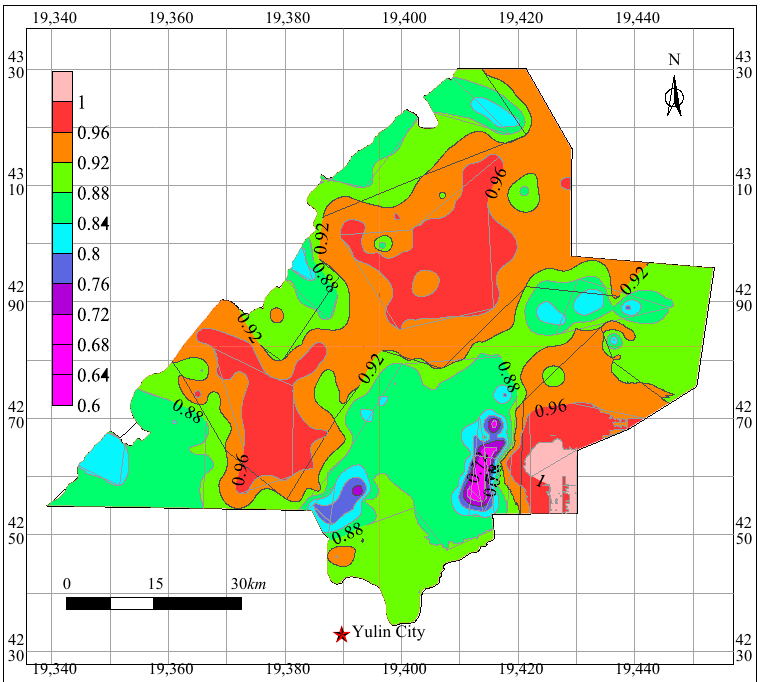
Figure 14. Contour map of the appropriateness of CO 2 sequestration using CECB and CMFB in the Yu-Shen coal area.